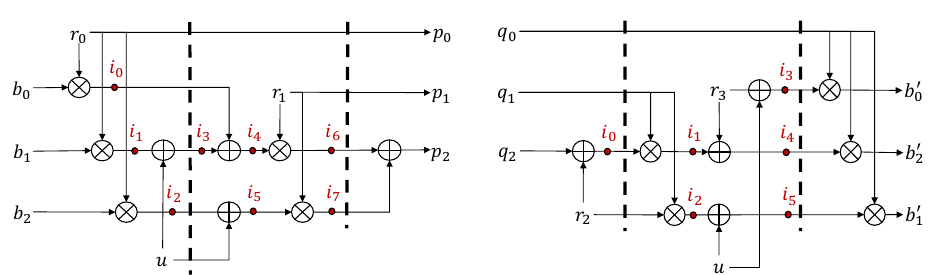
Figure 17: Second-order Boolean to multiplicative (left) and multiplicative to Boolean (right) conversion circuits with intermediate probes